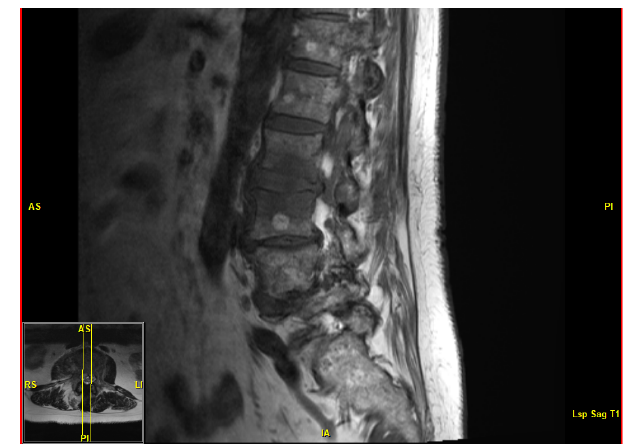
Figure 1. MRI demonstrating abnormal T2 hyperintensity with accompanying inflammatory changes at the L2–L3 level. Chronic multilevel severe spinal canal stenosis is also present.